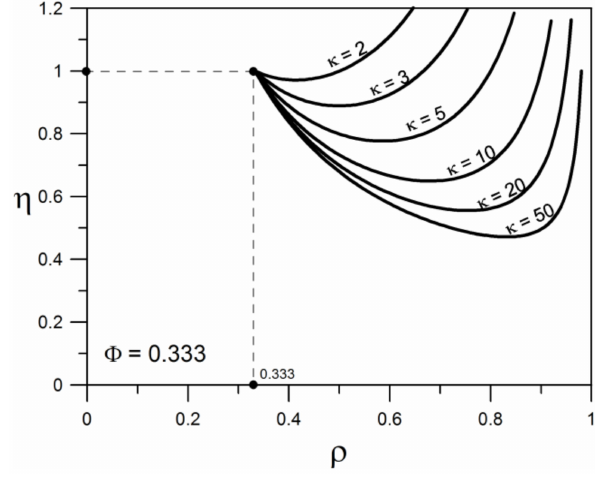
Figure 10. Relationship η = F 1 ( ρ , κ ).